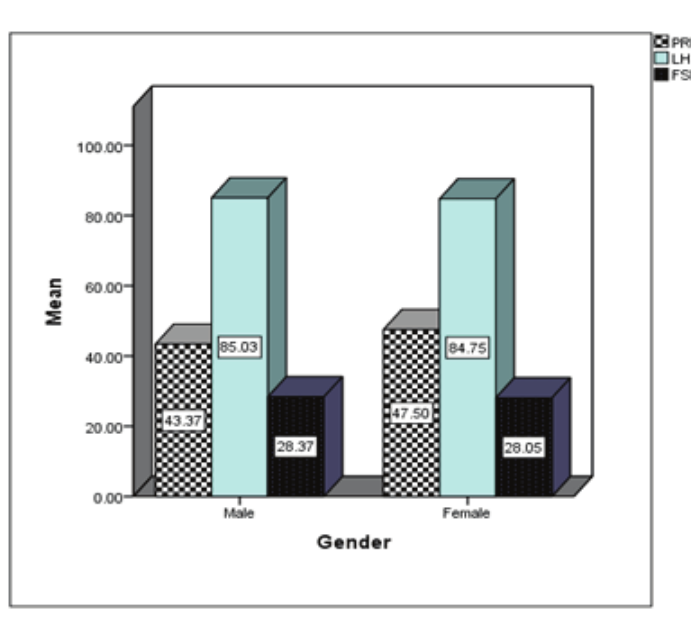
Figure 2 : Means of serum PRL, LH, and FSH among gender in chronic renal failure.